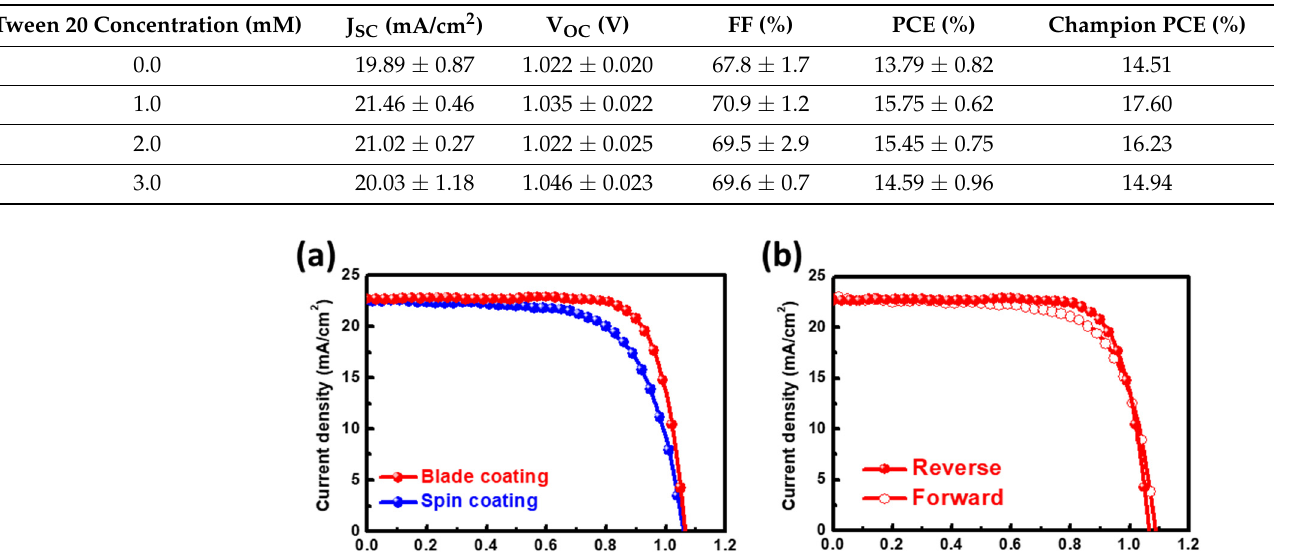
Figure 4. ( a ) The schematic diagram of PSC. ( b ) J-V curves of pristine, 1.0, 2.0, and 3.0 mM Tween 20 PSCs. ( c ) J-V curves and ( d ) EQE spectra of champion pristine and 1.0 mM Tween 20 PSCs. Table 2. Photovoltaic characteristics of pristine, 1.0, 2.0, and 3.0 mM Tween 20 PSCs. The average device parameters for 18 cells of same configuration are presented.